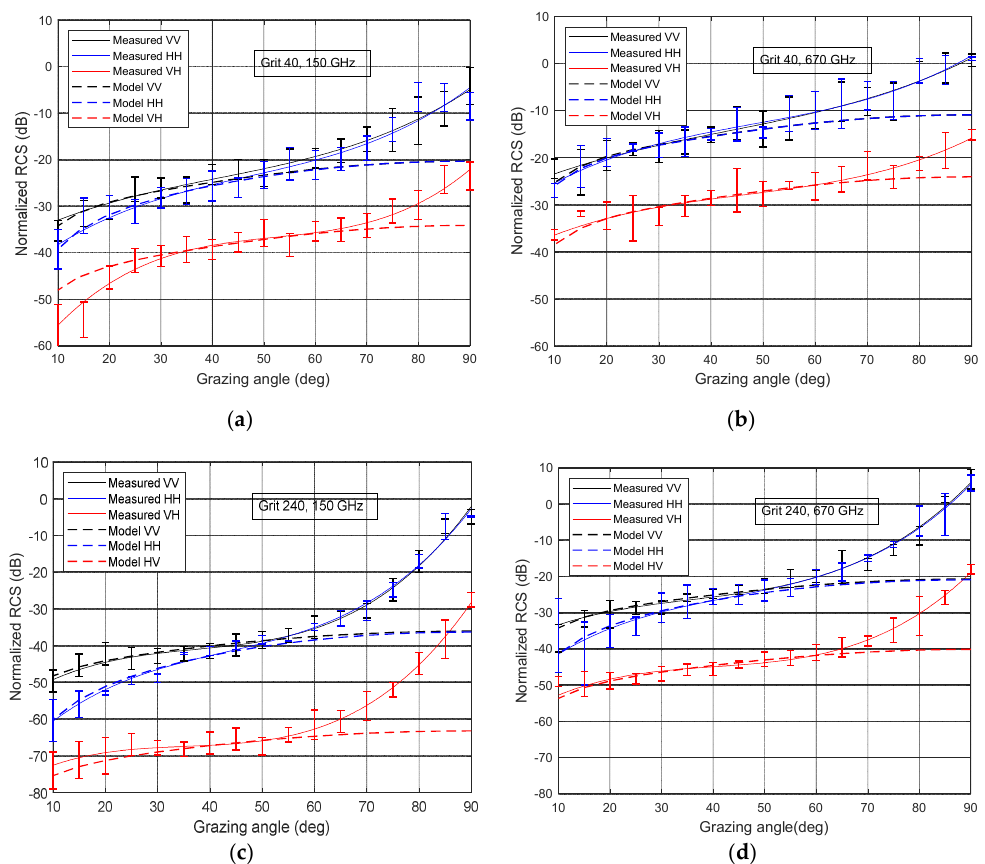
Figure 9. Measured and calculated normalized RCS: ( a ) grit 40 at 150 GHz, ( b ) grit 40 at 670 GHz, ( c ) grit 240 at 150 GHz, and ( d ) grit 240 at 670 GHz.